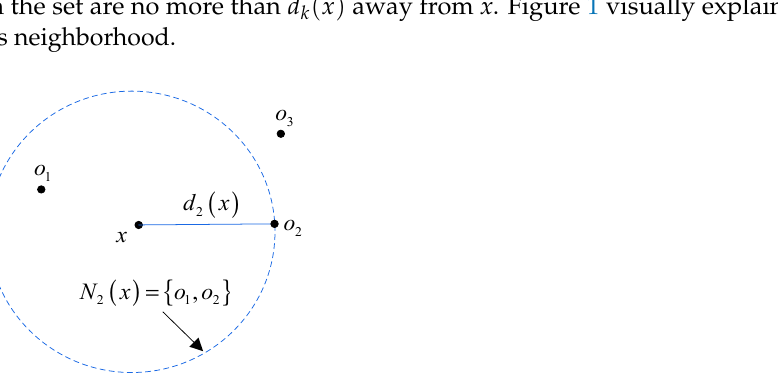
Figure 1. Illustration of k -distance and its neighborhood of the point x ( k = 2).